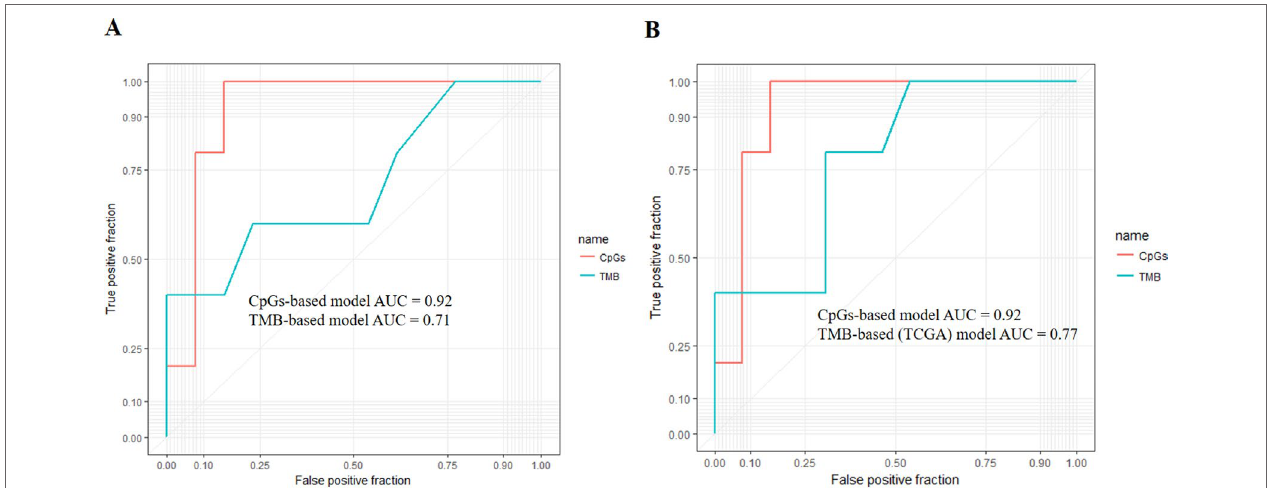
FIGURE 3 | (A) Performance comparison of the CpG-based model and tumor mutational burden (TMB)-based model. The area under the receiver operating characteristic curve (AUC) scores of the CpG-based model and TMB-based model were 0.92 and 0.71, respectively, which indicated that our model had better performance. (B) Performance comparison of the CpG-based model and TMB-based model using The Cancer Genome Atlas (TCGA) samples. The AUC scores of the CpG-based model and TMB (TCGA)-based model were 0.92 and 0.77, respectively, which indicated that our model had better